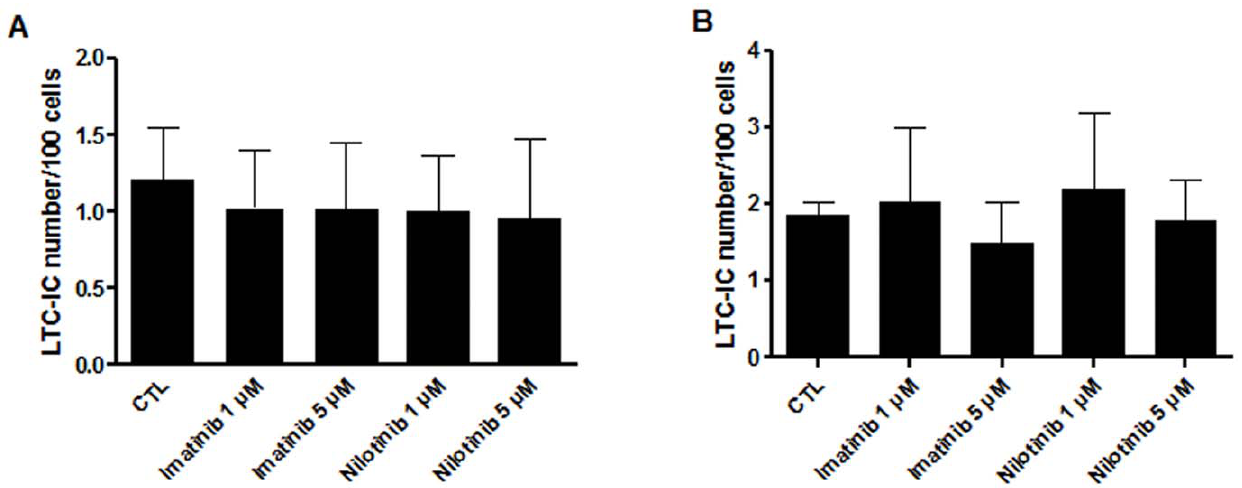
Figure 3. Neither imatinib nor nilotinib induce a decrease of LTC-IC frequency. ( A ) : Influence of a 48-hour pre-culture with imatinib or nilotinib at a final concentration of 1 or 5 m M on LTC-IC frequencies. ( B ) : LTC-IC generation with TKIs in a 6-week LTC-IC assay. Results are expressed as mean 6 SD. n=3, Student’s paired t tests. CTL: control condition without TKIs.